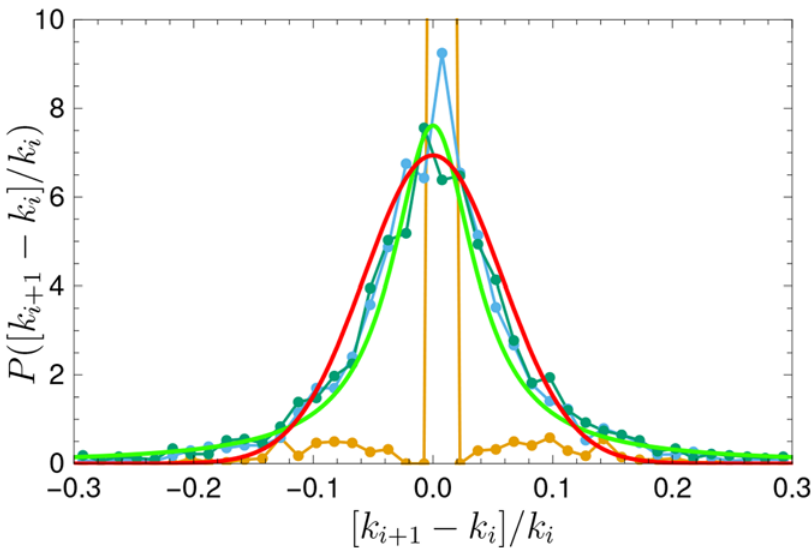
Fig 5. Distribution of relative size of frequency changes [ k t +1 − k t ]/ k t in the case of English for words in the head (gold) (that start with rank between 1 and 10), the body (blue)(rank between 200 and 210), and the tail (green) (rank between 5000 and 5010). Notice that for words in the head, the granularity of the model (Equation 3) shows up as large deviations from the Gaussian. For the body and tail, the relative jumps are similar independently of the initial rank of the word. We also show, as a thick green curve, the Lorentzian distribution which best fits the average of the curves for the body and tail. A Gaussian, with zero mean and the most common standard deviation ^ s ¼ 0 : 0575 , is also shown in red for comparison (see text for details). The corresponding plot for other languages is shown in the supplementary